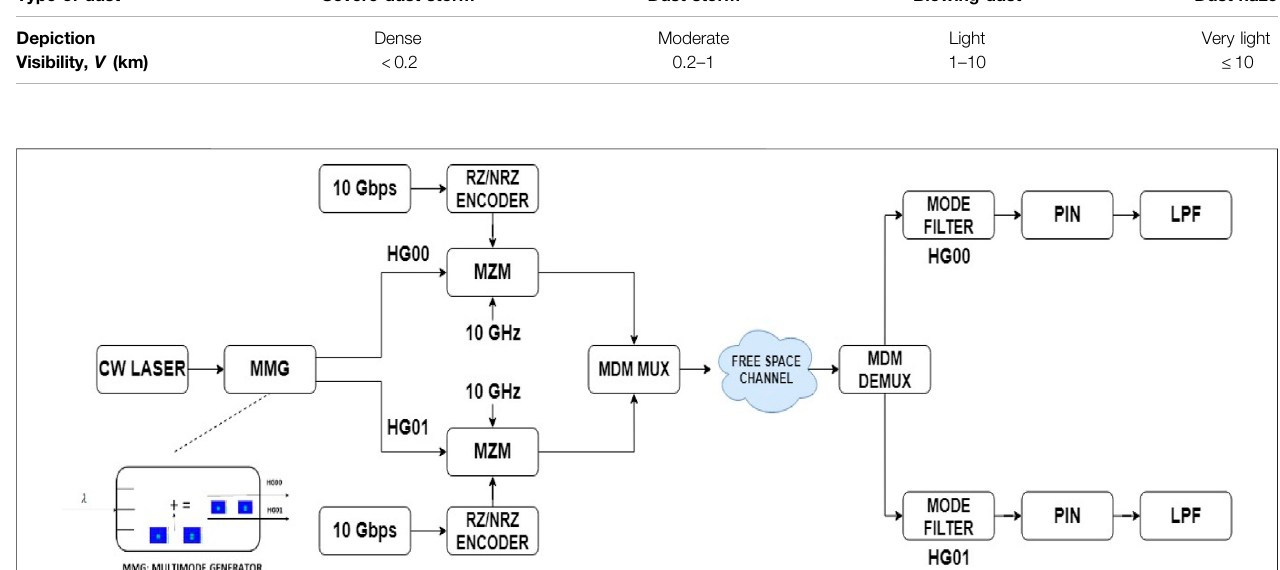
FIGURE 1 | Design schematic of the proposed RoFSO transmission link employing MDM.